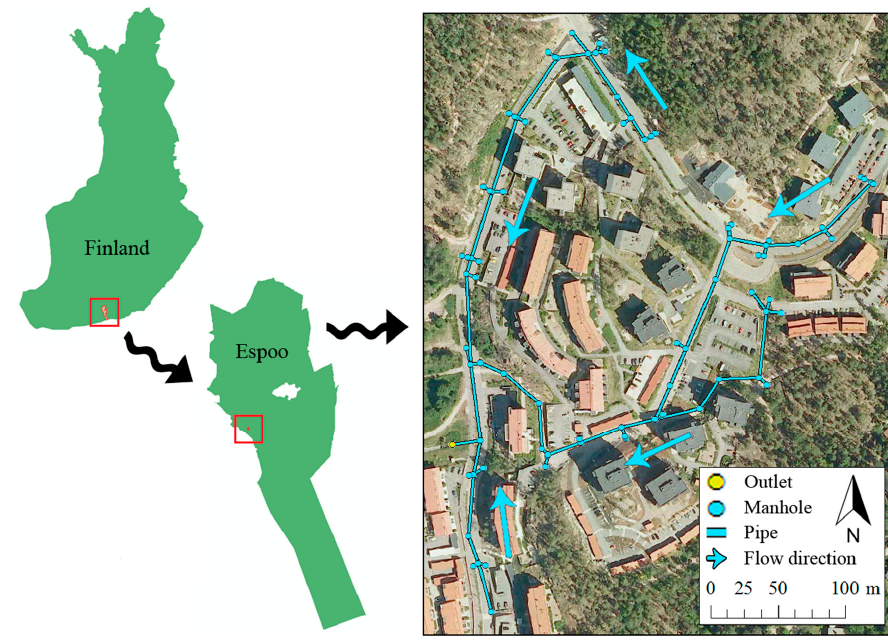
Figure 4. Location of the study catchment and arrangement of its sewer network.